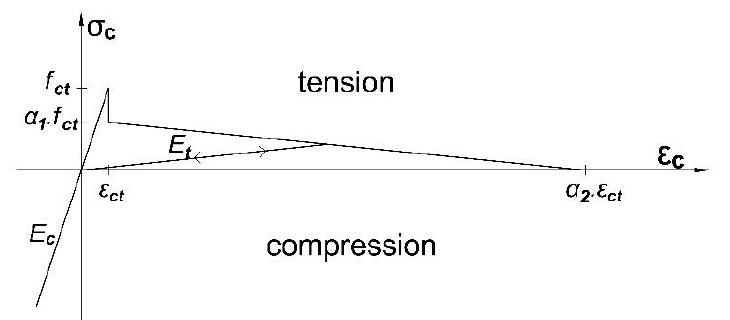
Figure 15. Equivalent stress–strain relationship for tensioned concrete [64].